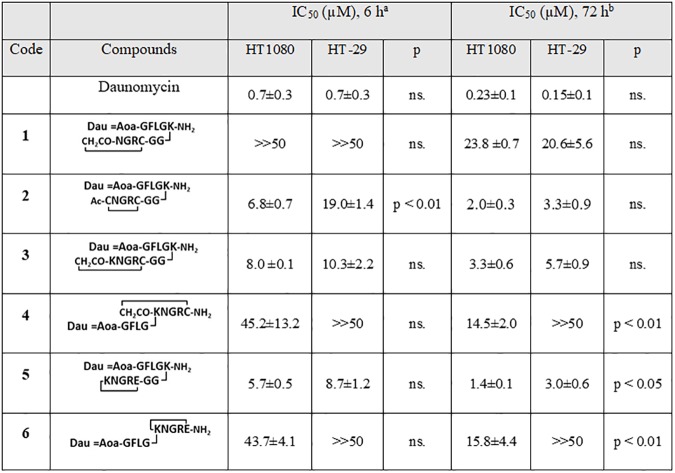
Cytostatic/cytotoxic effect of cyclic NGR peptide–daunomycin conjugates.aTests were carried out 4 times; btests were carried out 3 times; IC50 values were averaged; statistical significance was calculated using unpaired t-tests.